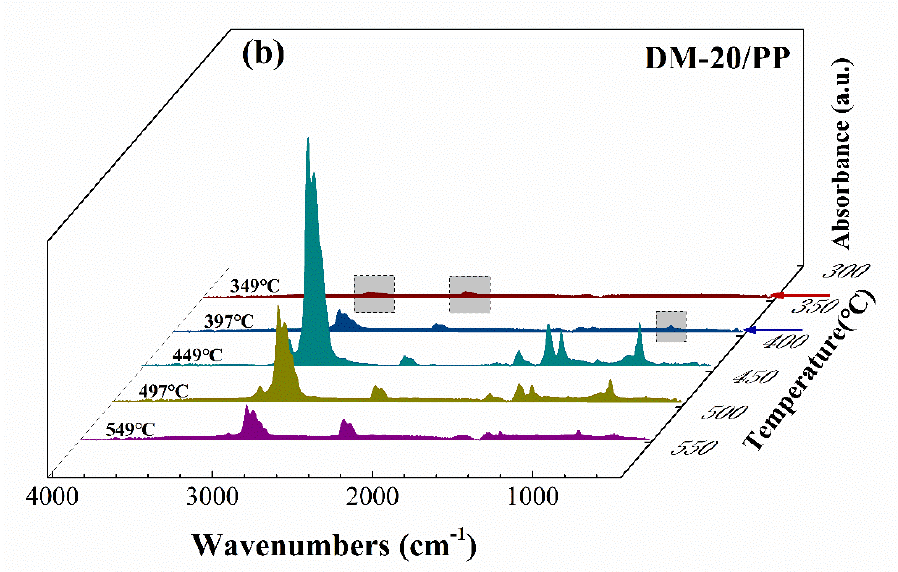
Figure 3. Three-dimensional TG–FTIR diagrams of pyrolysis products of ( a ) pure PP and ( b ) DM– 20/PP. dimensional TG FTIR diagrams of pyrolysis products of ( a ) pure PP and ( b ) DM Figure 3. Three 20/PP. - –